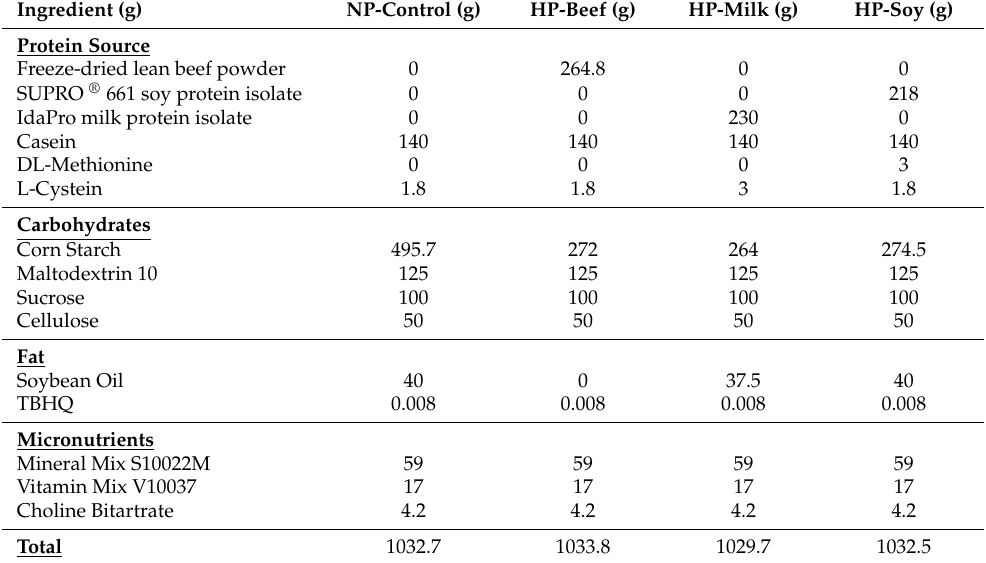
Table 1. Energy restricted diet formulation 1